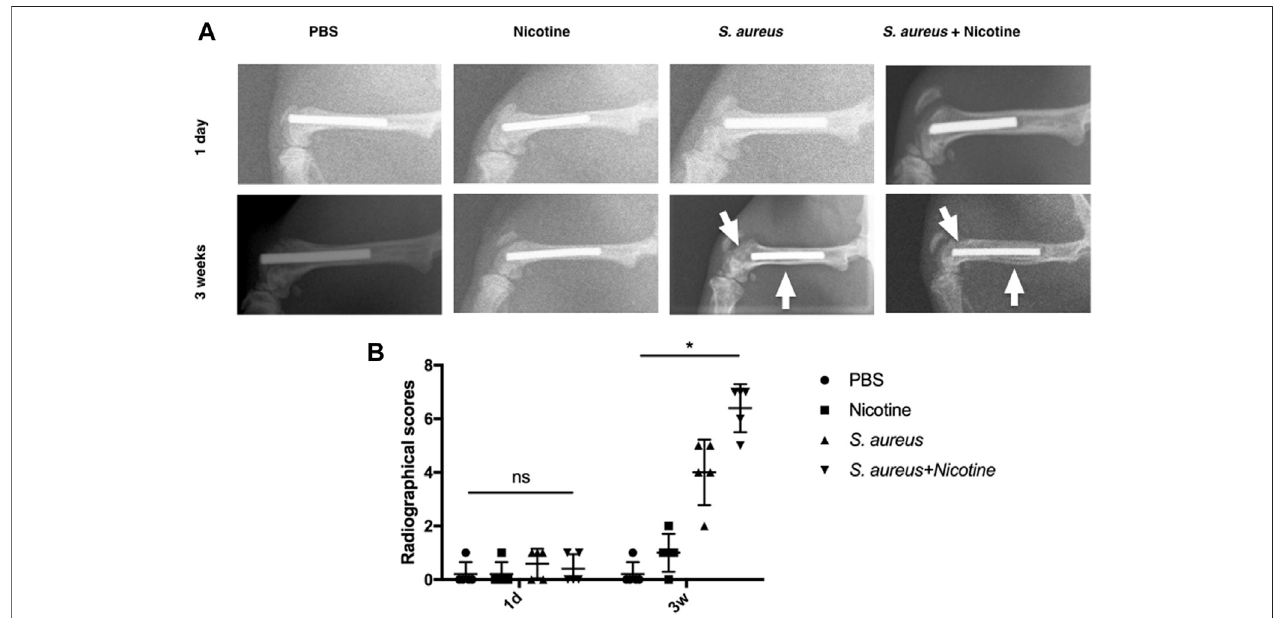
FIGURE 2 | Nicotine and S. aureus synergistically induced the osteolysis and periosteal reactions. (A) X-ray images ofrat femurs with Tirod implants at one day or three weeks after surgery. White arrows indicate osteolytic lesions and cortical bone destruction. (B) Radiographical scores of X-ray images. * p < 0.05. ns: p S 0.05.